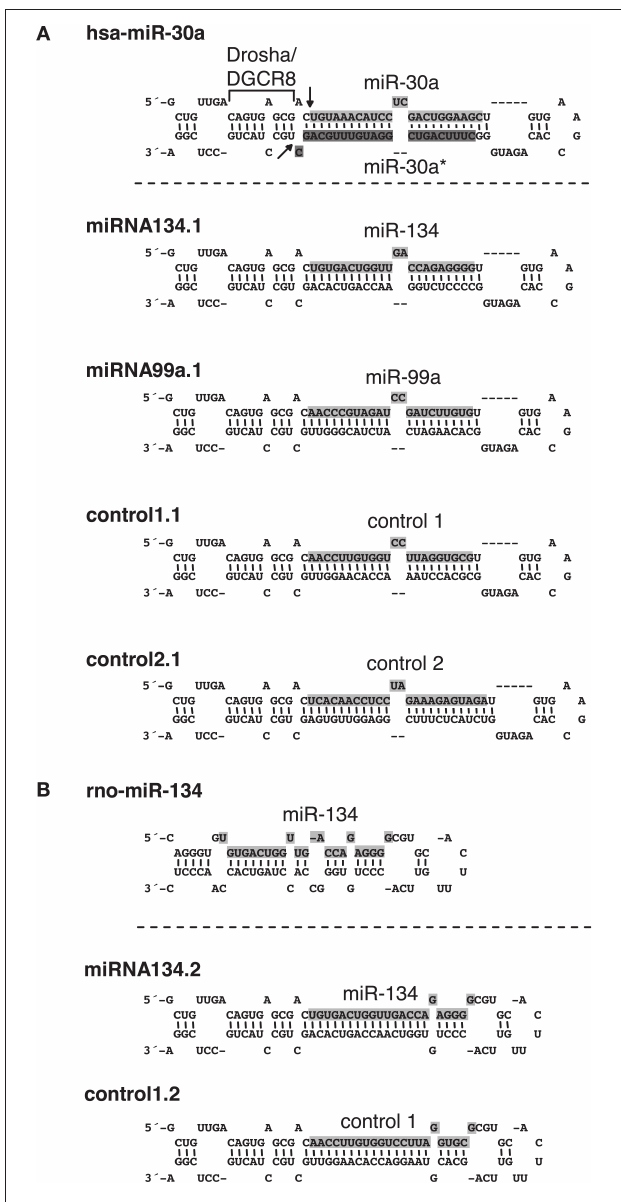
FIGURE 1 | Secondary structures and sequences of chimeric hairpins. (A) Top: structure and sequence of the hsa-miR-30a hairpin including fl anking sequences required for Drosha processing. Light grey shaded sequence: miR-30a mature sequence. Dark grey shaded sequence: miR-30a* mature sequence. Drosha/DGCR8: fl anking region of the miR-30a hairpin required for Drosha processing. Arrows: site of Drosha cleavage. Bottom: structure and sequence of chimeric hairpins, design 1 (see text for details). Shaded sequence: miRNAs or control sequences expressed from the chimeric hairpins. (B) Top: structure and sequence of the rno-miR-134 hairpin. Shaded sequence: miR-134 mature sequence. Bottom: Structure and sequence of chimeric hairpins, design 2 (see text for details). Shaded sequence: miRNAs or controls expressed from the chimeric hairpins. was substituted by the single stranded terminal loop from